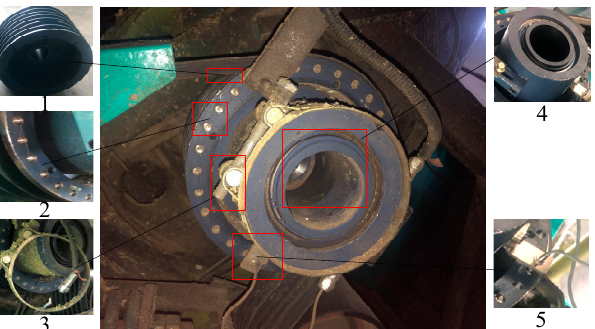
Figure 3. Physical view of blowing power sensor. 1: elastic pulley; 2: velocimetric panel; 3: mounting base; 4: torque sensor; 5: speed sensor.